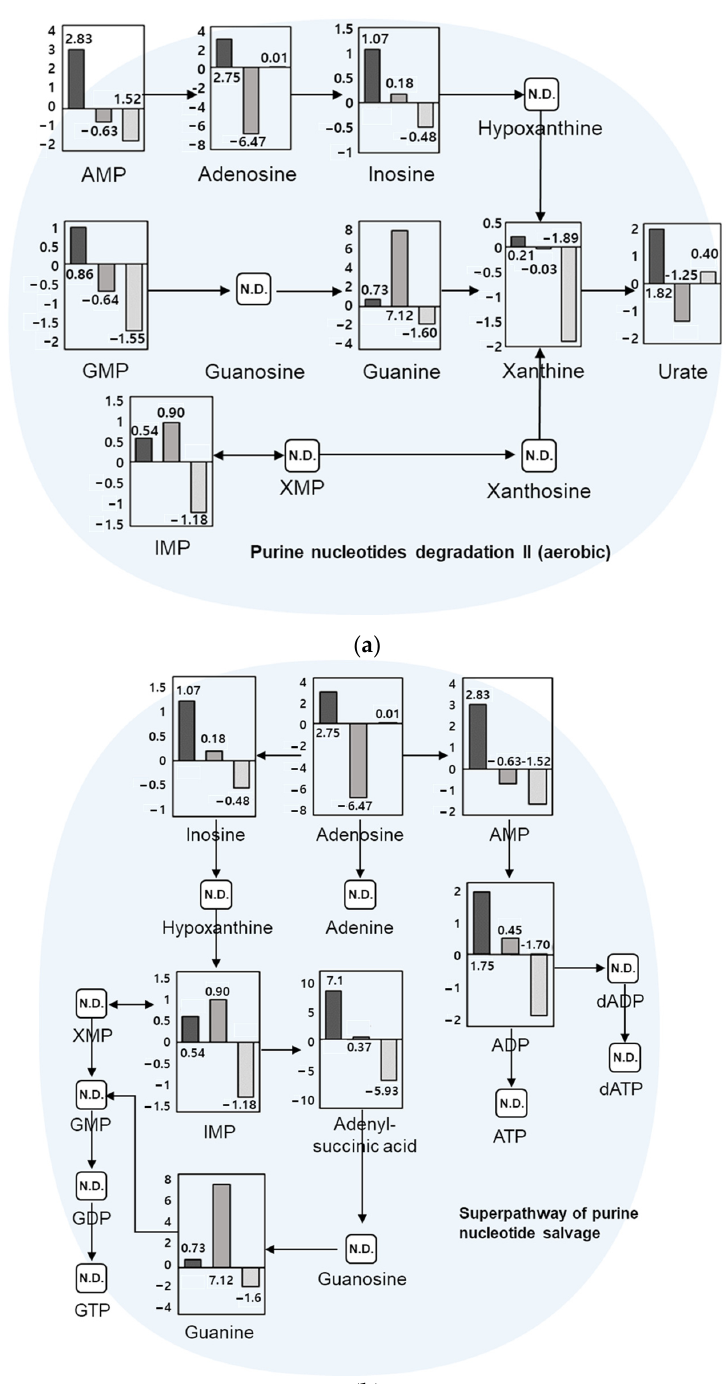
Figure 4. Metabolic pathways through the KEGG database, including ( a ) purine nucleotides degra- dation II (aerobic) and ( b ) superpathway of purine nucleotide salvage. Log2 fold-change quantitative values were for day 5 vs. day 3, day 9 vs. day 5, and day 11 vs. day 9, from left to right, respectively. AMP: adenosine monophosphate; ADP: adenosine diphosphate; ATP: adenosine triphosphate; dADP: deoxyadenosine diphosphate; dATP: deoxyadenosine triphosphate; GMP: guanosine monophosphate; GDP: guanosine diphosphate; GTP: guanosine triphosphate; IMP: inosine monophosphate; XMP: xanthosine monophosphate.